Question: Is the quantity shown trending increasing or decreasing?
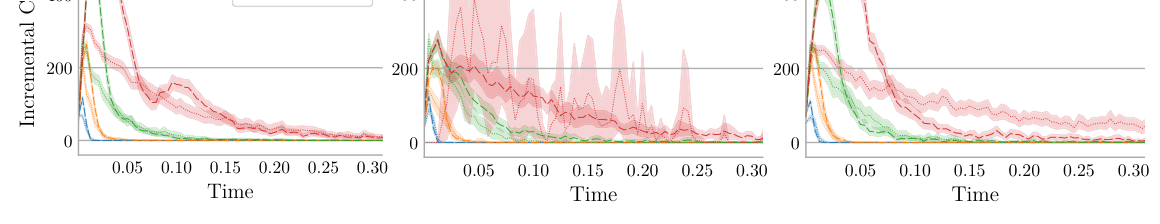
Answer: increasing